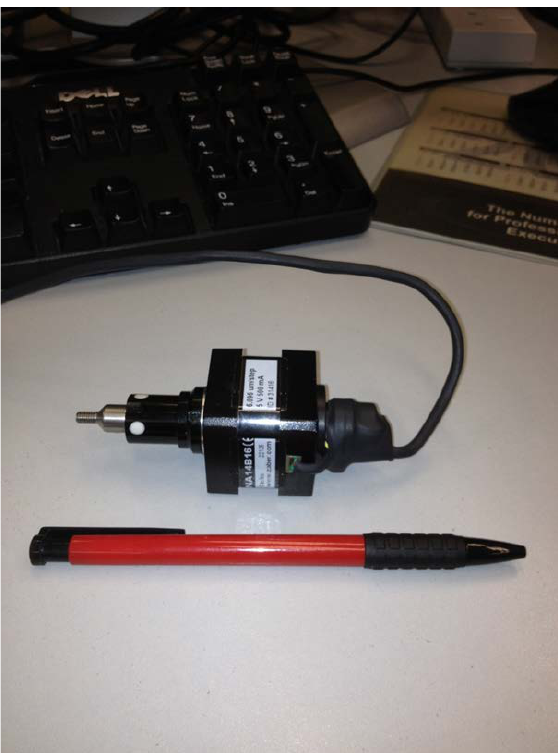
Figure 7. Image of a linear micro-stepper motor which is part of the micromechanical sliding apparatus.